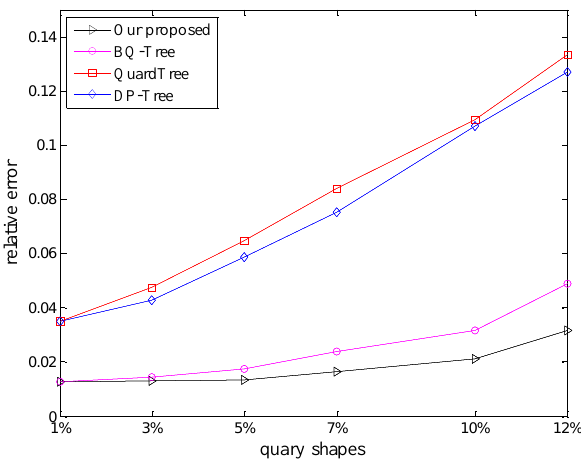
Figure 8. Privacy budget ε = 0.1.